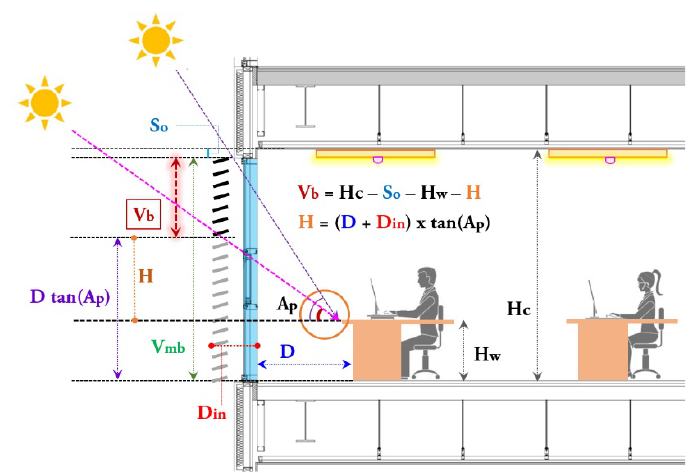
Figure 4. Concept of vertical height control [33].